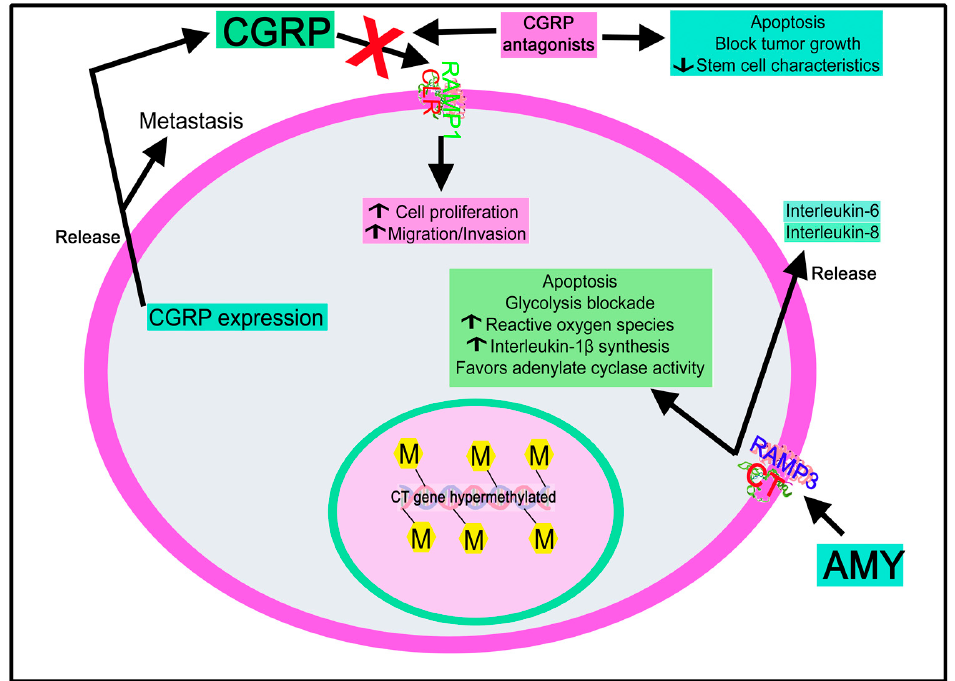
Figure 15. Summary of the mechanisms mediated by adrenomedullin 2 (AM2) in tumor cells. Akt: Ak strain transforming protein kinase; CLR: calcitonin receptor-like receptor; ERK 1/2: extracellular signal-regulated protein kinase; MAPK: mitogen-activated protein kinase; MMP9: matrix metalloproteinase 9; PI3K: phosphatidylinositol 3-kinase; RAMP1/2/3: receptor activity modifying protein 1, 2 and 3; VEGF-A: vascular endothelial growth factor A. ↑ : increase; ↓ : decrease.